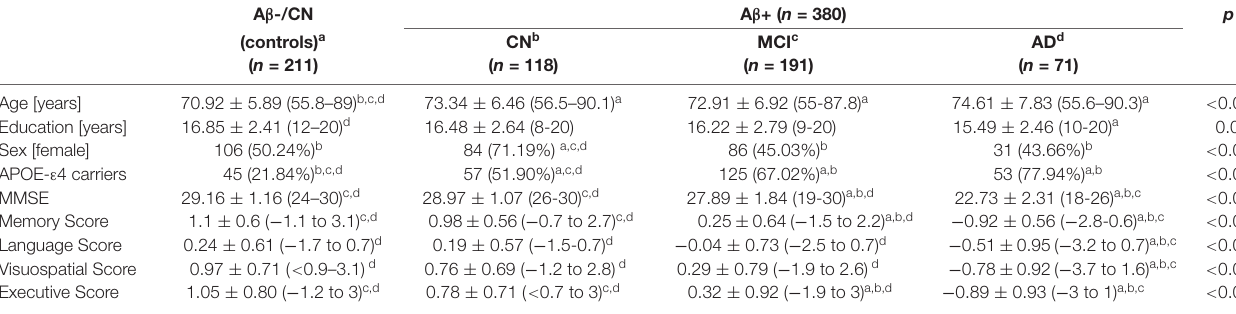
TABLE 1 | Baseline characteristics of the participants.